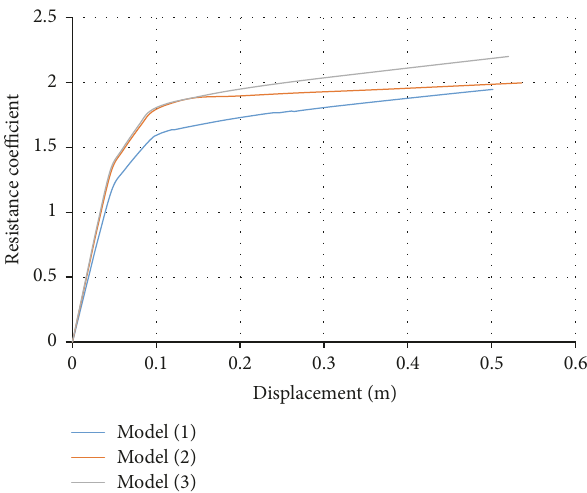
Figure 20: Displacement-resistance curve of the three models with different steel ratio after the bottom corner column was